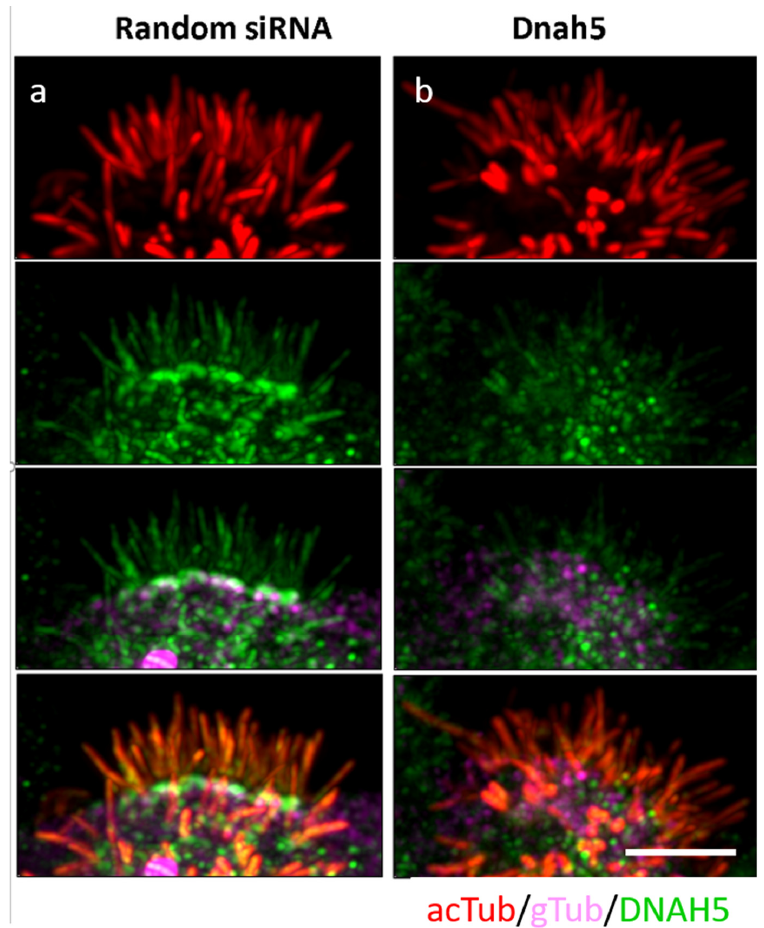
Figure 4. Immunofluorescence staining of reciliated spheroids treated with scrambled, random siRNA ( a ) or Dnah5 knockdown ( b ). Cells were fixed and stained for acetylated tubulin (cilia-top row-red), gamma tubulin (basal body-purple), and Dnah5 (green). In the siRNA treated sample, there is expression of Dnah5 (green) in cilia (red). This expression is significantly decreased in poorly ciliated Dnah5 knockdown spheroids ( b ). Scale bars represent 4